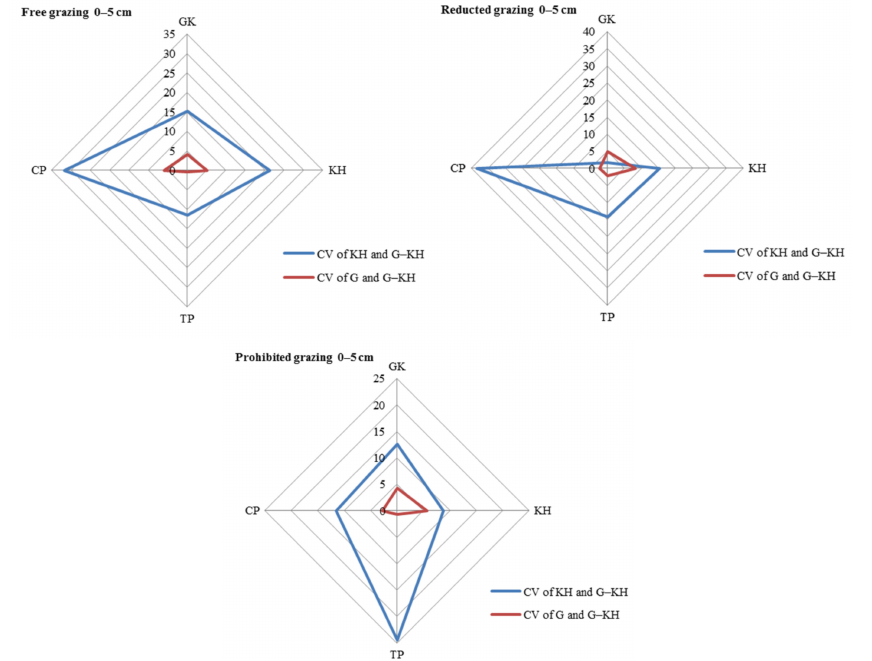
Figure 7. Coefficient of variation (CV) in soil organic matter content in the 0–5 cm layer between micro-patches in the degradation stages. Notes: CV of KH and G-KH: CV between the Kobresia and Kobresia -Gramineae transitional micro-patches; Free grazing 0–5 cm, Reduced grazing 0–5 cm, and Prohibited grazing 0–5 cm: CV in the free-grazing, reduced-grazing, and grazing-prohibited areas, respectively; GK, Gramineae- K. humilis meadow; KH, K. humilis meadow; TP, K. pygmaea meadow with mattic epipedon thickening; CP, K. pygmaea meadow with mattic epipedon cracking.